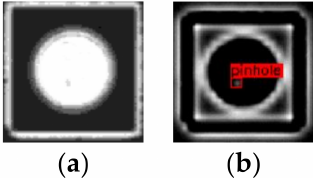
Figure 8. Electrode-pinhole-missing: ( a ) shallow pinhole; ( b )